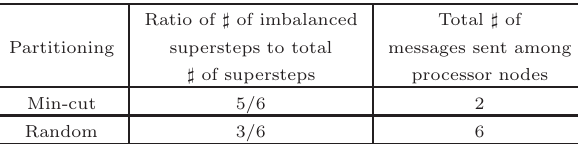
Table 1. Summary of tradeoffs between Communication and Computation cost for the SSSP example Ratio of ♯ of imbalanced Total ♯ of Partitioning supersteps to